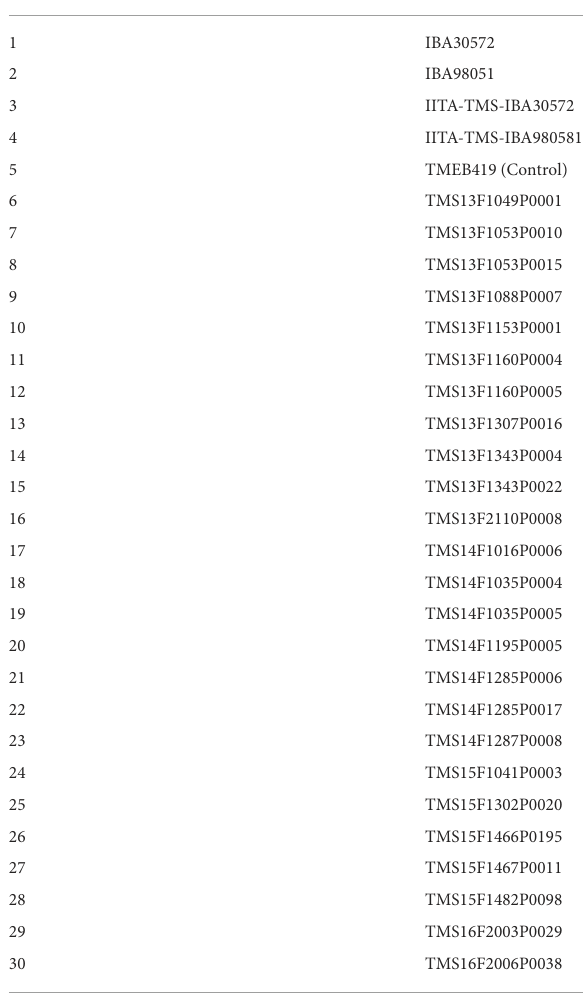
TABLE 1 Improved cassava genotypes and the control variety used to produce gari/eba